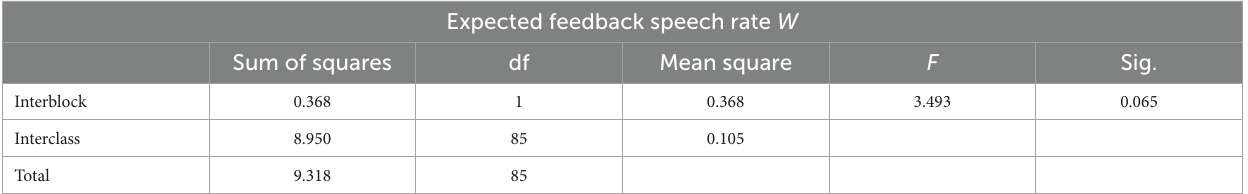
TABLE 8 One-way ANOVA test for expected feedback speech rate in different types of dialog tasks.